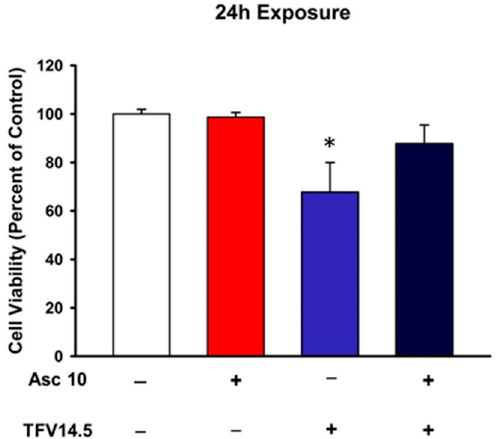
Figure 8. Effects of ascorbic acid on Tenofovir cytotoxicity. Ascorbic acid did not alter cell viability relative to vehicle control. Ascorbic acid protected HK-2 cells from tenofovir cytotoxicity as assessed by MTT viability. Cells were treated with 0 ( − ) or 10 µ M (+) ascorbic acid. Followed by a 24 h exposure to 0 ( − ) or 14.5 µ M TFV (+). An asterisk (* p < 0.05) indicates statistical difference from all other groups. Values represent Mean ± SEM for three independent experiments run with three biological replicates.